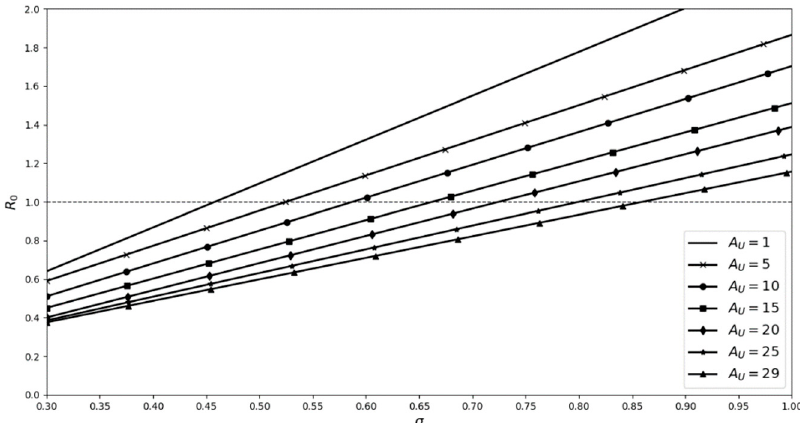
Figure 10. Ro values for the introduction of one A H individual to populations with differing numbers of A U , while the total population size remains constant at 30. The number associated with each line indicates the number of A U individuals present in the population. (M D(U) = 0.775, Ψ = 0.45, M N = 0.2) A s is the number of susceptible individuals, Ψ is the contact rate, σ is the likelihood of transmission, M N is the natural mortality rate, and M D is the mortality rate associated with ranavirosis.